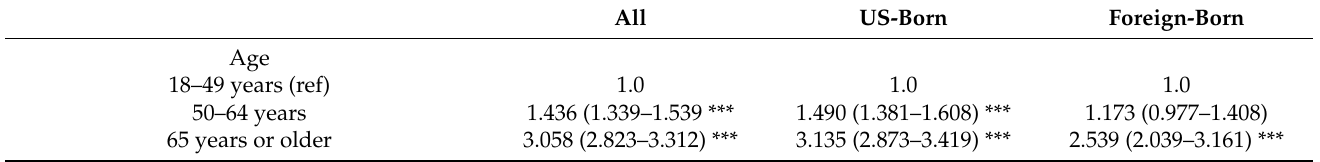
Figure 1. Influenza vaccination uptake and moderation effect of nativity. ( a ) Influenza vaccination uptake by nativity and race/ethnicity (%); The differences in Figure 1a were statistically significant based on chi-squared tests ( p =0.000); ( b ) Moderation effect of nativity on the relationship between influenza vaccination uptake and race/ethnicity. Table 2. Factors associated with influenza vaccine uptake by nativity. All